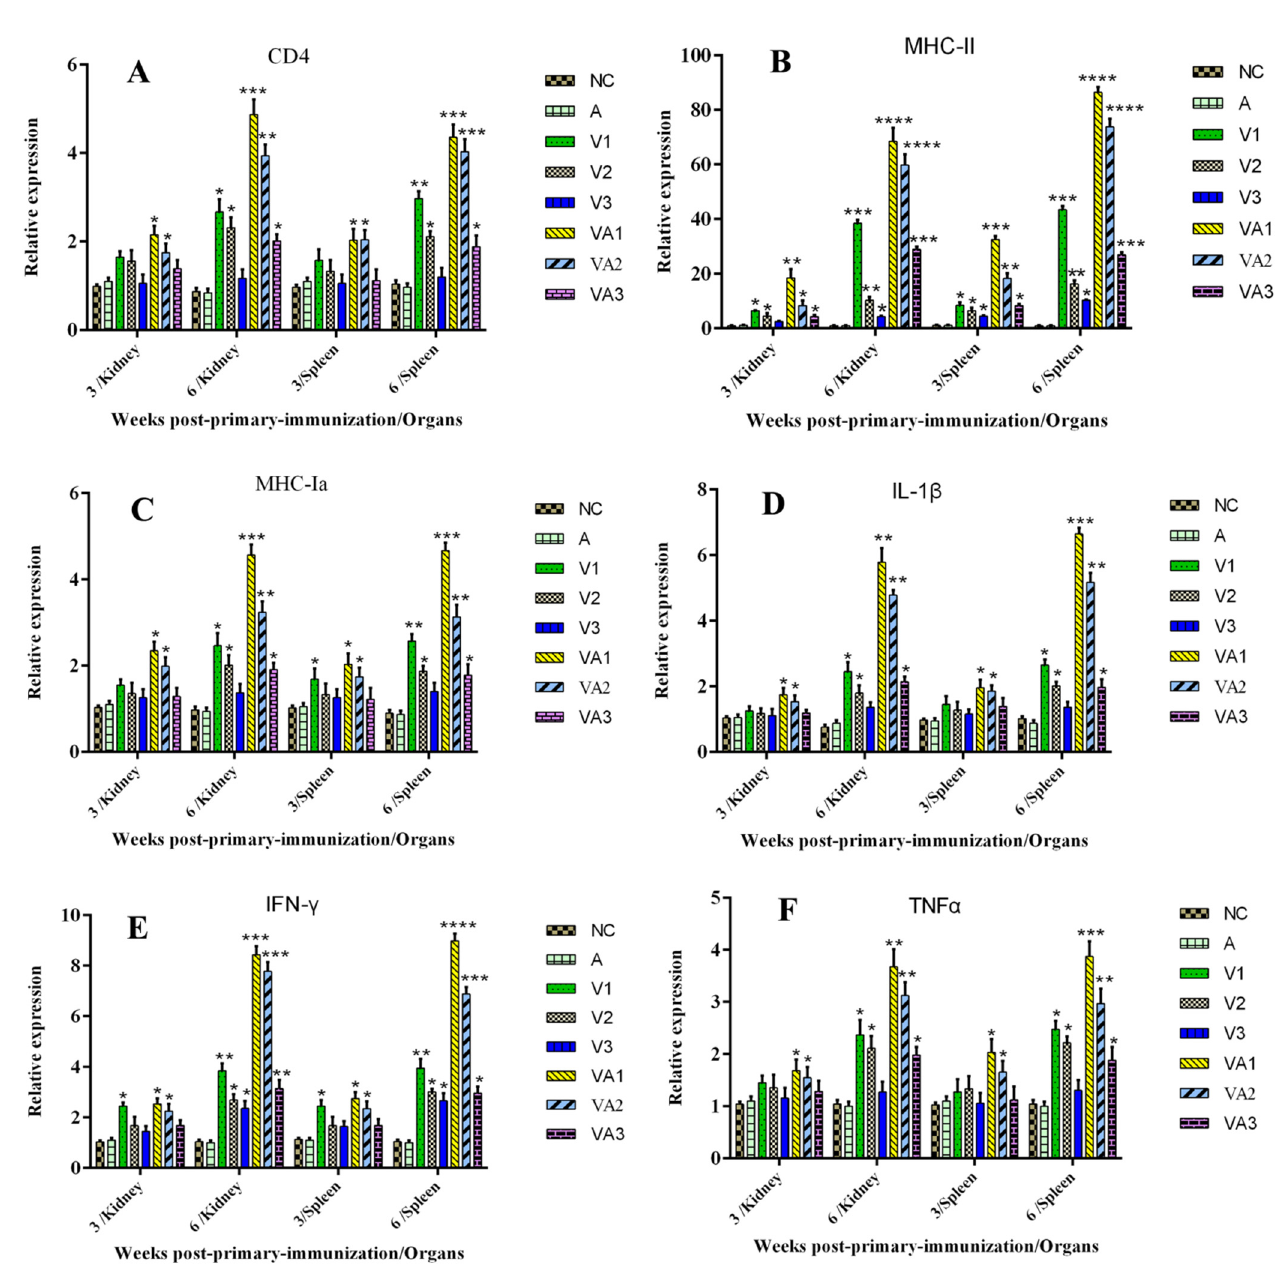
Figure 3. qRT-PCR analysis of the expression of immune-related genes in kidney and spleen of tilapia: ( A ) CD4, ( B ) MHC-II, ( C ) MHC-Ia, ( D ) IL-1 β , ( E ) IFN- γ , and ( F ) TNF- α . Five samples of each group were collected from the tilapia at three and six weeks post primary immunization (WPPI). Data were presented as the means ± SD. A comparison between the vaccinated groups V1, V2, V3, VA1, VA2, and VA3 with the NC or A groups is shown. Differences in the mRNA expression levels between vaccinated and control fish were analyzed by the Student’s t -test. * p < 0.05, ** p < 0.01, *** p < 0.001 and **** p < 0.0001.